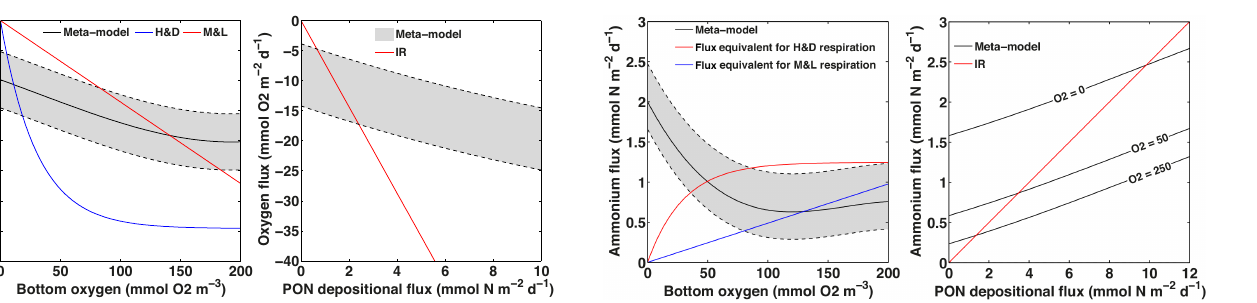
Figure 10. O 2 flux in the meta-model compared to that from the IR, H&D and M&L parameterizations as a function of bottom O 2 con- centration (left) and of POM depositional flux (right). The grey area and the black line in the left panel correspond to the variation in O 2 flux when 1< F POM <10mmolNm − 2 d − 1 and F POM = 5mmol Nm − 2 d − 1 , respectively. The grey area in the right panel corre- sponds to the variation in O 2 flux when bottom O 2 concentra- tion ranges from 0 to 200mmolO 2 m − 3 . The comparison between H&D, M&L and SOC observations can be found in Fennel et al. (2013) and Yu et al. (2015).